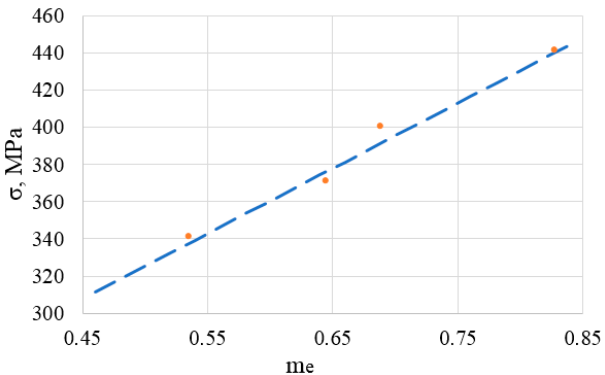
Figure 4. σ max versus m e graph for alloy D16ChATW taking into account cyclic deformation condi- tions realized.